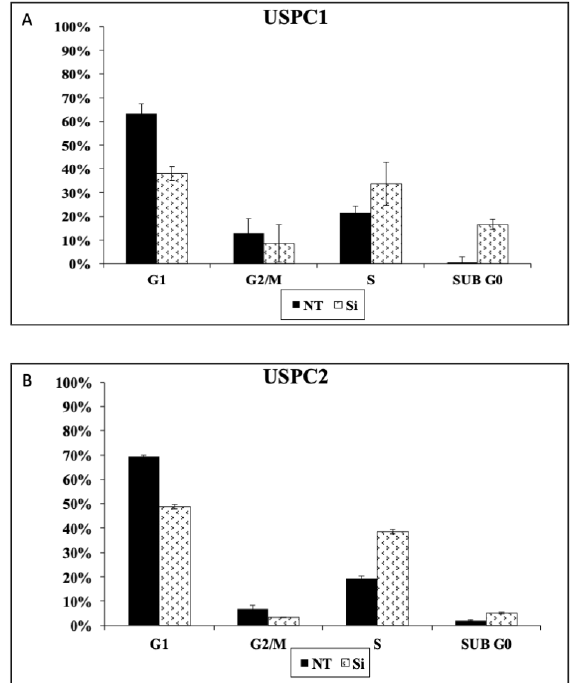
Figure 8. Effect of OR5H2 knockdown on cell cycle progression. USPC1 ( A ) and USPC2 ( B ) cells were seeded in quadruplicate dishes and transfected with OR5H2 siRNA or non-targeting siRNA for 72 h or 48 h, respectively. Cell cycle distribution was assessed by FACS analysis. The figure shows the results of a representative experiment repeated three times with similar results.